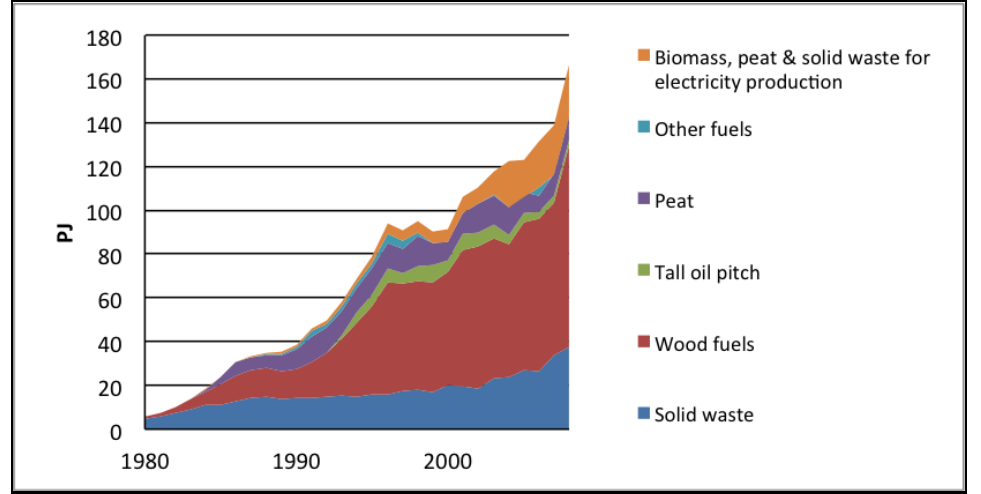
Figure 2. Production of energy (petajoule) from biomass, peat, and solid waste in district heating (predominantly combined heat and power plants) in Sweden (1980–2008) [2].